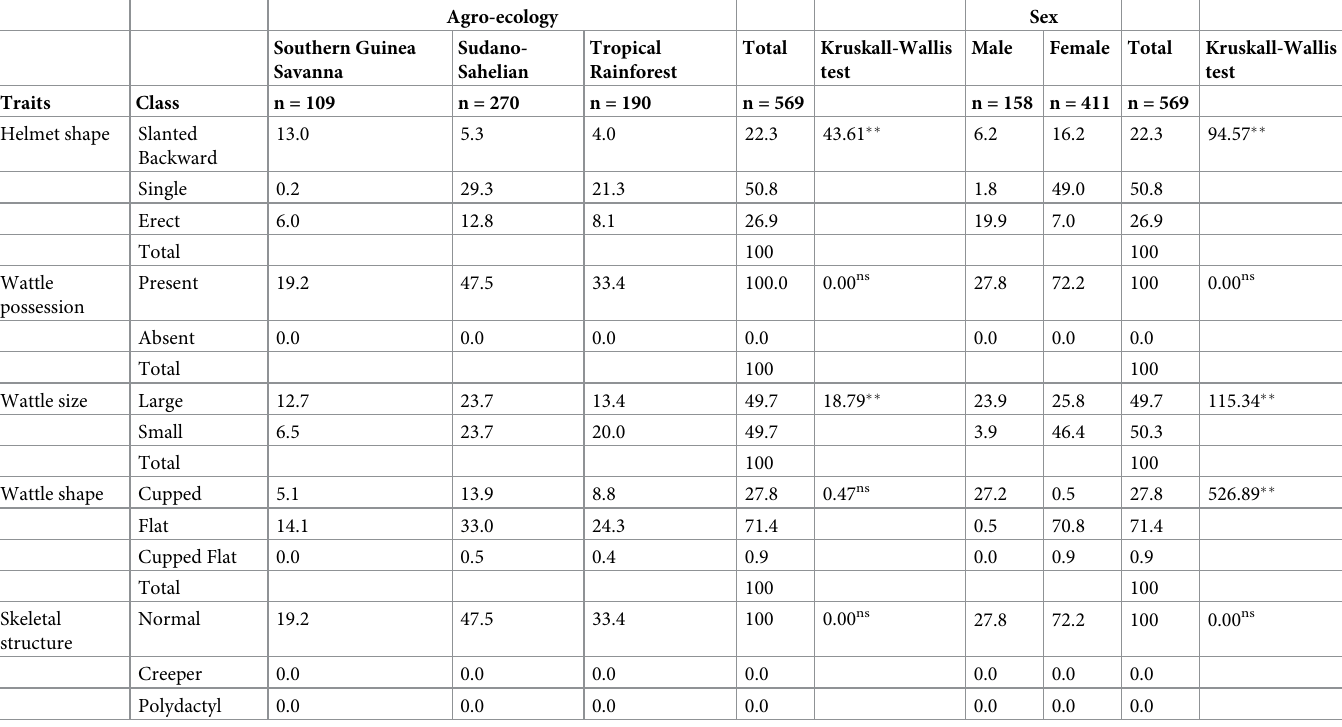
Table 2. Frequency (%) of helmet shape, wattle possession, size and shape including skeletal structure of indigenous helmeted Guinea fowl based on agro-ecology and